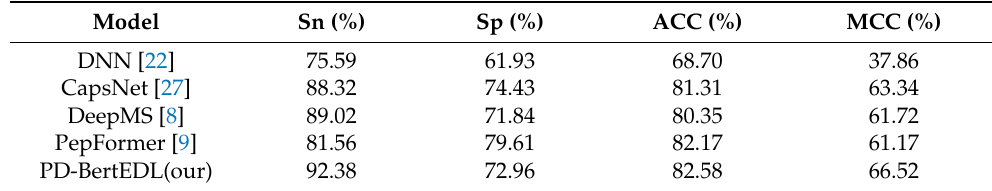
Table 4. The results of PD-BertEDL and other predictors on the independent test set of Homo sapiens .